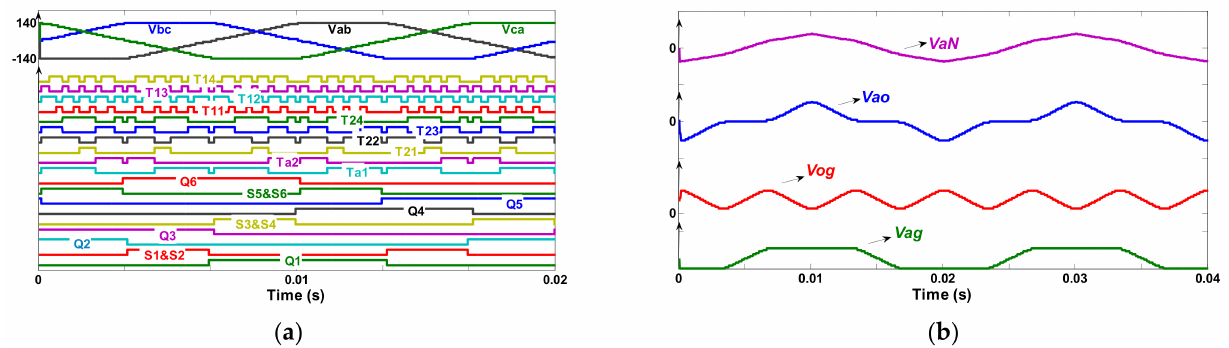
Figure 6. For ( n = 2, N = 15, f = 50 Hz) ( a ) Switching gate signals and Vab , Vbc and Vca , ( b ) Simulated waveforms of VaN , Vao , Vog and Vag